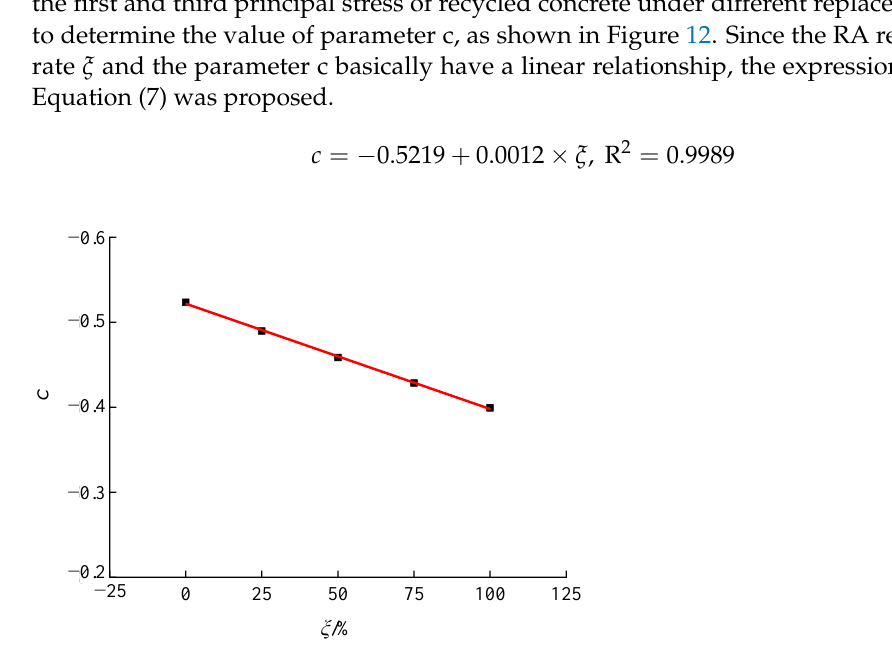
Figure 12. Relationship between the RA replacement rate and parameter c. was obtained, as shown in Figure 11 and Equation (8).